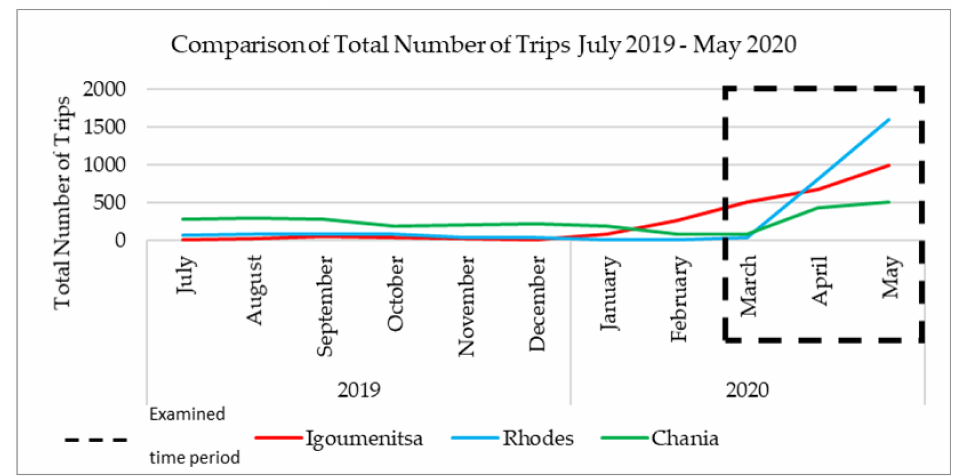
Figure 9. Comparison of the total number of trips for the cities of Igoumenitsa, Rhodes, and Chania